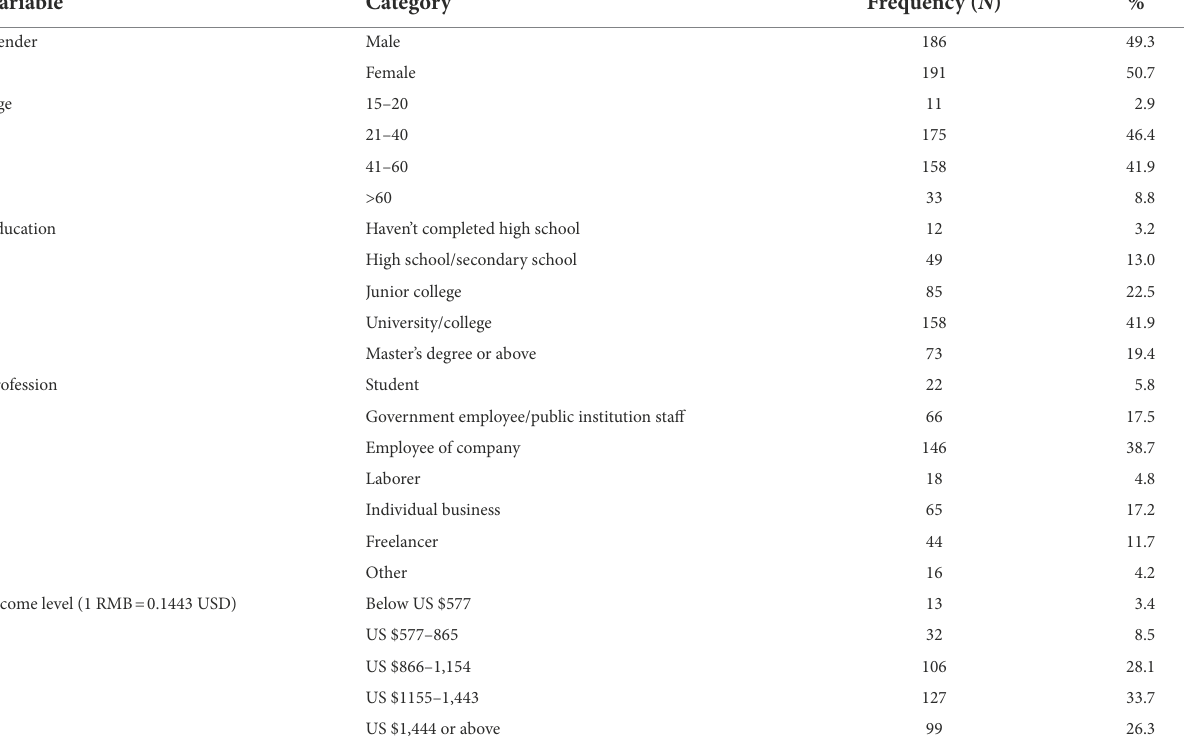
TABLE 1 The demographic characteristics ( N =